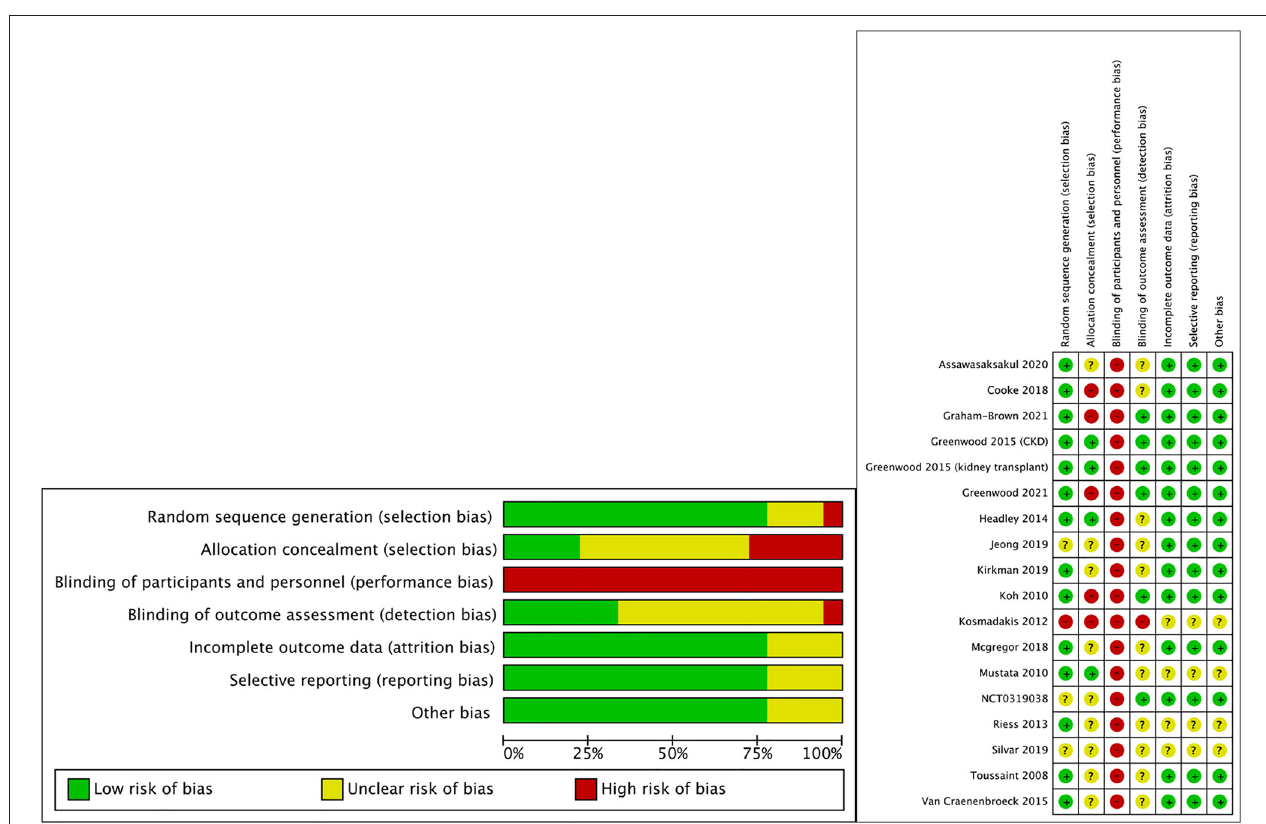
FIGURE 2 | Risk of bias graph of included